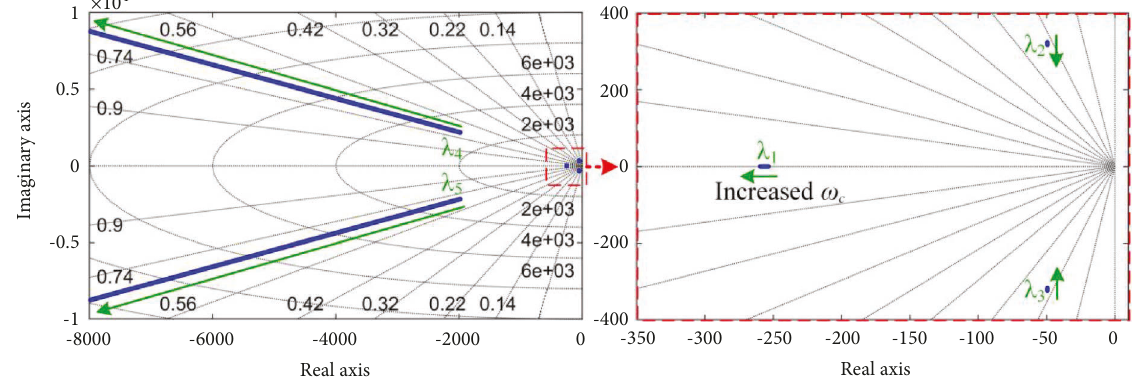
Figure 12: Generalized root locus diagram with a variation of ω